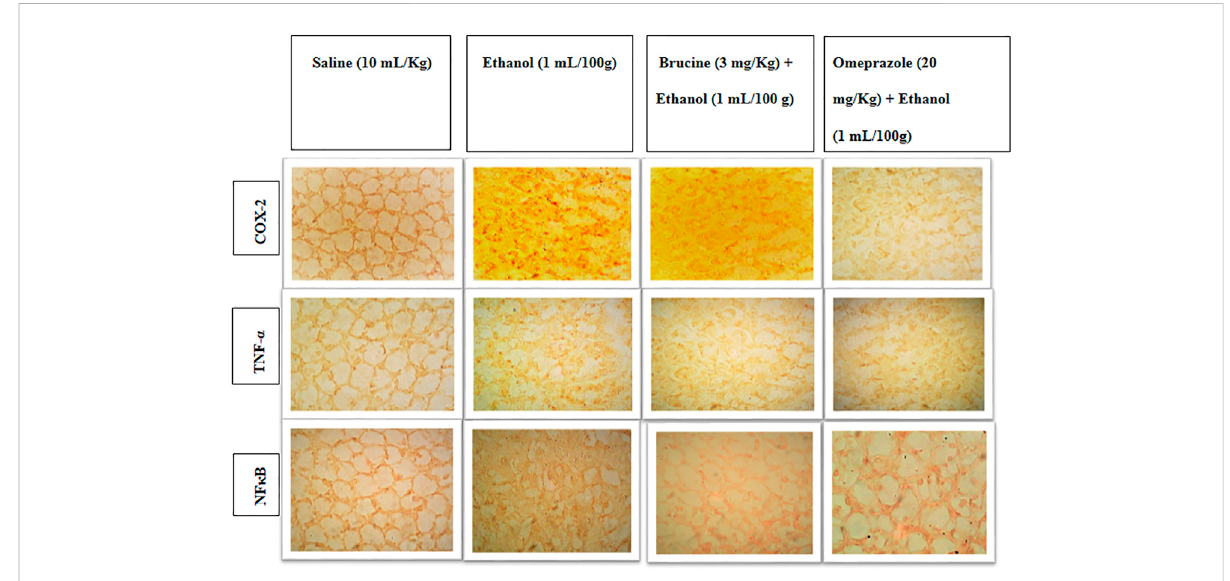
FIGURE 6 Slidesrepresenttheeffectofbrucineandomeprazoleagainsttheexpressionsofcyclooxygenase(COX-2),nuclearfactorkappaB(p-NF κ B),and